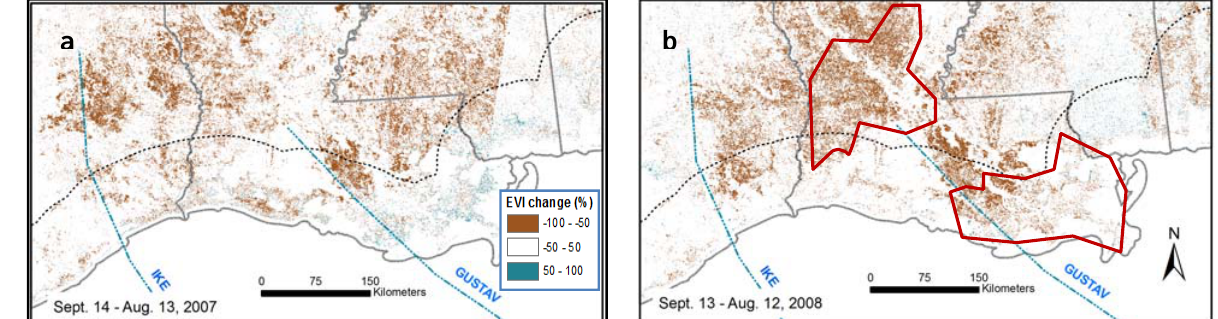
Figure 4. Greater than 45% decrease of the MODIS EVI values between two dates as shown on the maps. The images on the left column as references, display the changes without hurricane disturbance. The maps on the right column represent the changes after Hurricanes Gustav and Ike